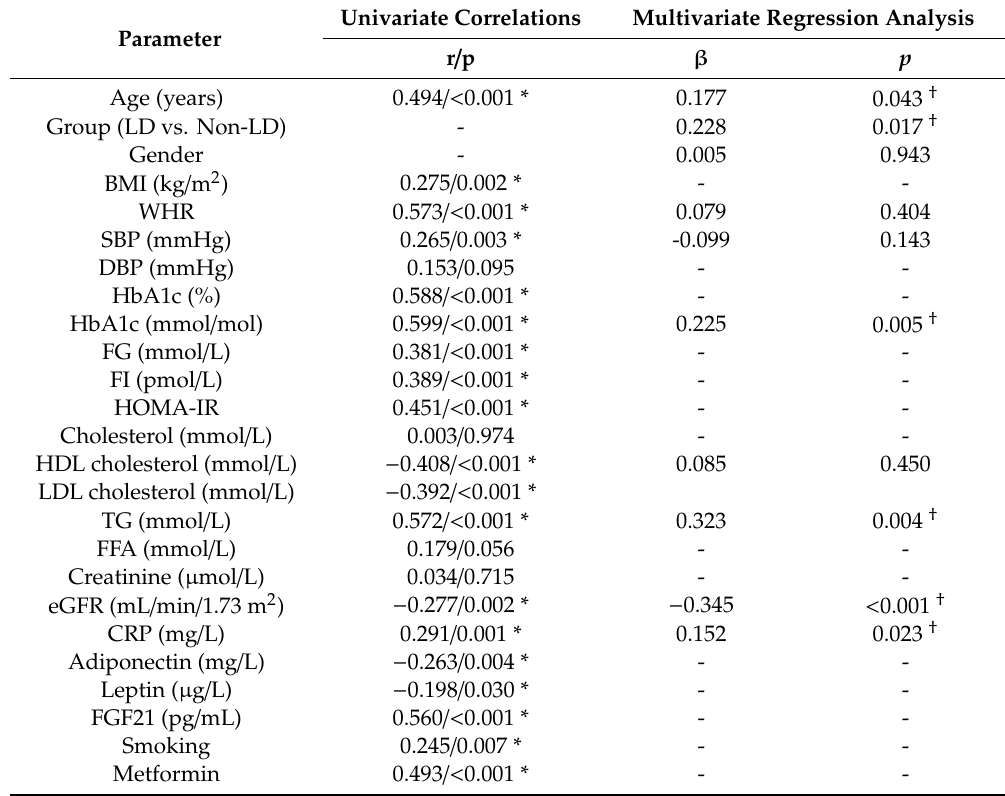
Table 2. Univariate correlations with GDF15 in the entire study population and multivariate regression analysis between GDF15 (lg; dependent variable) and age, group, gender, WHR (lg), SBP (lg), HbA1c (lg), HDL cholesterol (lg), LDL cholesterol, TG (lg), eGFR (lg), as well as CRP (lg). Non-normally distributed variables were logarithmically transformed (lg) prior to multivariate testing. r- and p -values, as well as standardized β -coe ffi cients and p -values, are given, respectively. Abbreviations are indicated in Table 1. * indicates significant correlation as assessed by Spearman’s correlation method. † indicates significant correlation in multivariate